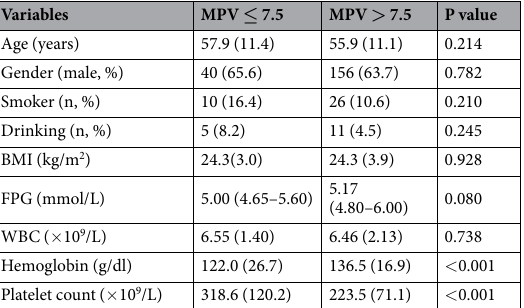
Table 2. Baseline characteristics of patients with renal cell carcinoma according to MPV levels. Data are expressed as means (SD) or median (IQR). FPG, fasting plasma glucose; WBC, white blood cell; MPV, mean platelet volume. Abbreviations: see to Table 1.